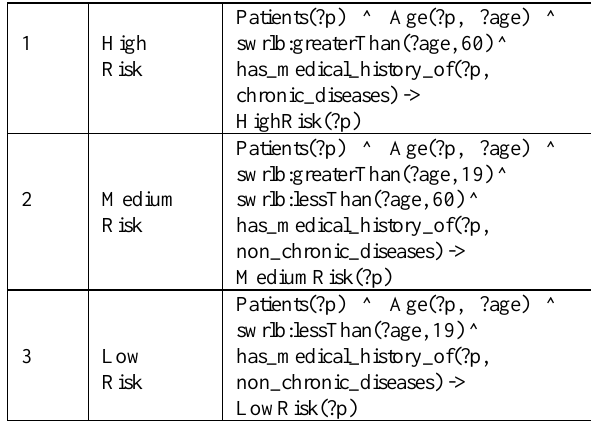
Table 5. SWRL rules for recommending Covid-19 risk